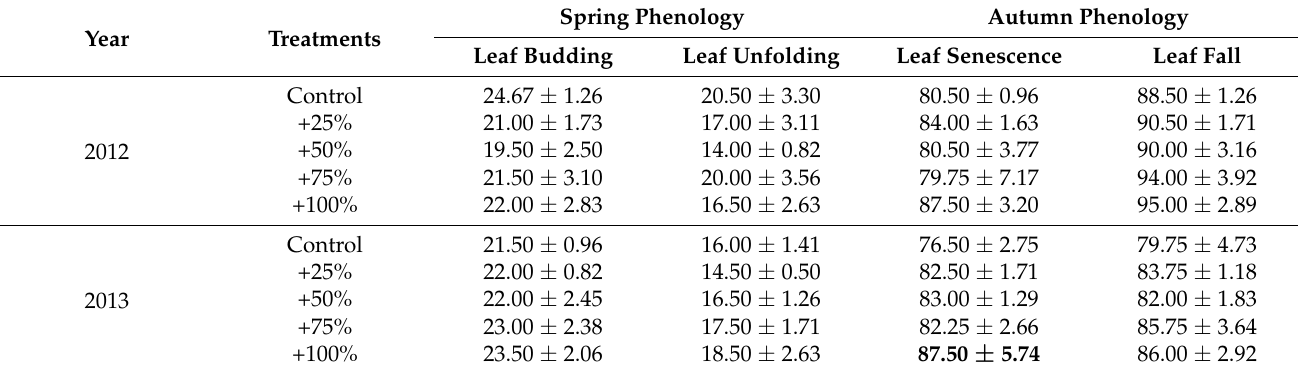
1 indicates a significant difference compared with that of the control. Values in bold are significantly different from control ( p <